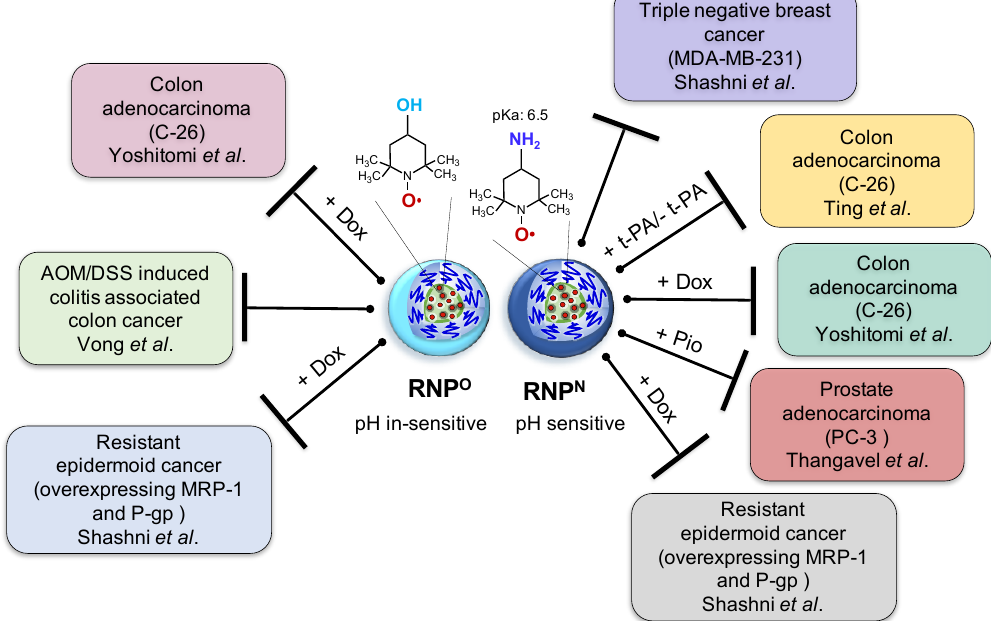
Figure 1. Illustration displaying the therapeutic efficacy of pH sensitive redox nanoparticle (RNP) N and pH in-sensitive RNP O in various cancer models as stand-alone or as adjuvants with conventional anti-cancer drugs; doxorubicin (Dox) and pioglitazone